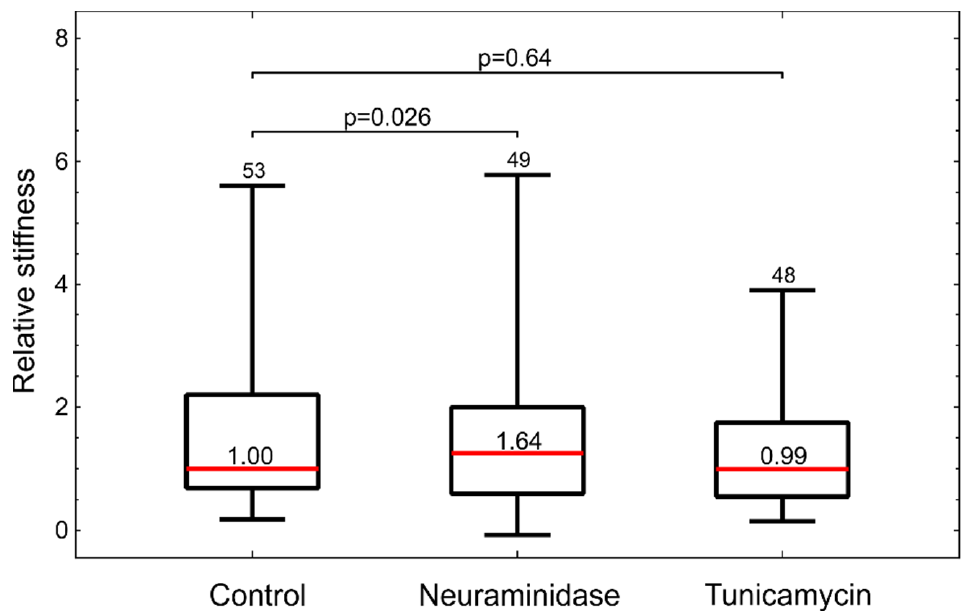
Figure 6. Stiffness of treated HUVEC cells measured by optical tweezers. Cell stiffness is given relative to the control. The red horizontal lines represent the medians, boxes span over 50% of the data points, and the whiskers span over the total data range. The median value is indicated in the box, the number of measured cells indicated at the top and the p -values describe the difference relative to the control. The results were obtained from four independent experiments.